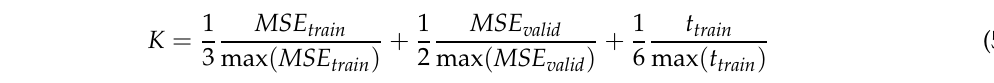
IC ; ( b ) ANN CP ; ( c ) ANN IP